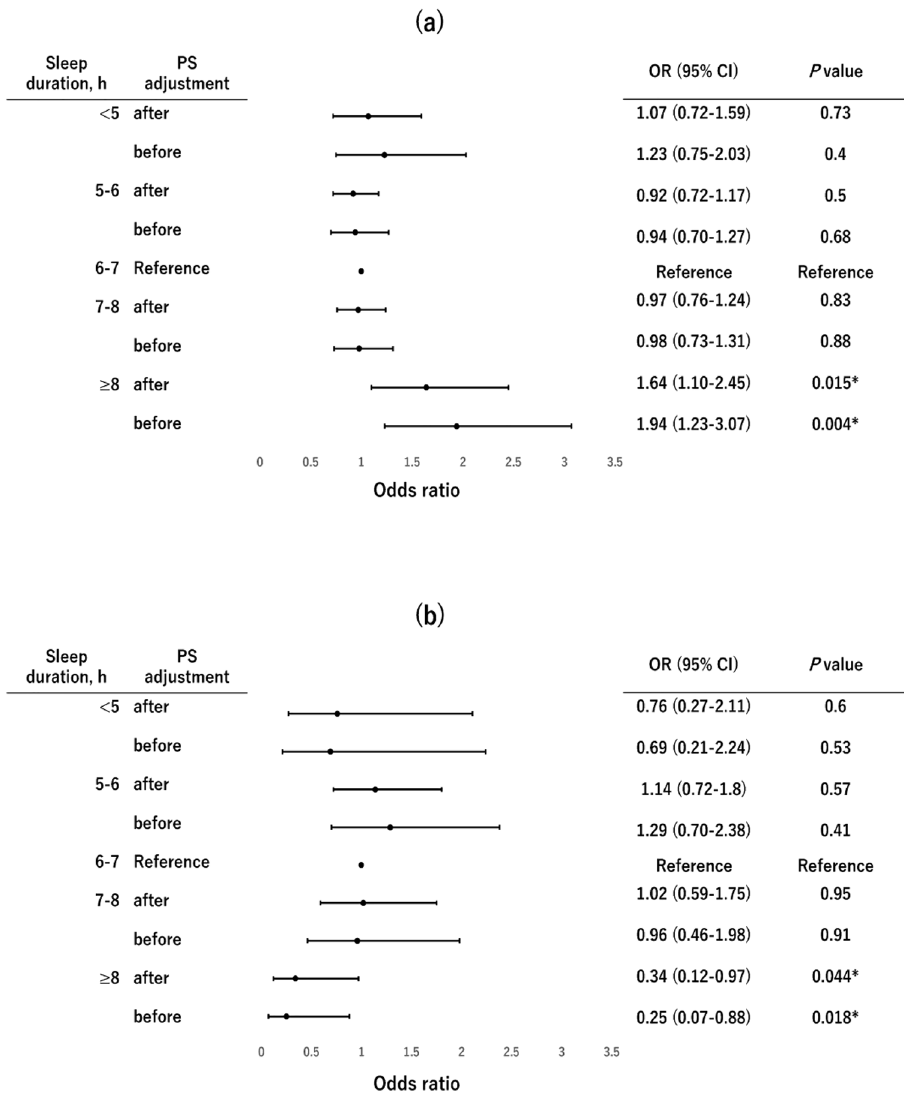
Figure 2. Forest plots of odds ratios and 95% confidence intervals before and after propensity score adjustment. Forest plots of the odds ratios (OR) and 95% confidence intervals (CI) of each sleep duration group for visceral obesity in men ( a ) and women ( b ). Sleep duration was categorized as follows: < 5, 5–6, 6–7, 7–8, and ≥ 8 h. OR and 95% CI were calculated using logistic regression models both before and after propensity score (PS) adjustment. The 6–7 h sleep group was taken as a reference for both men and